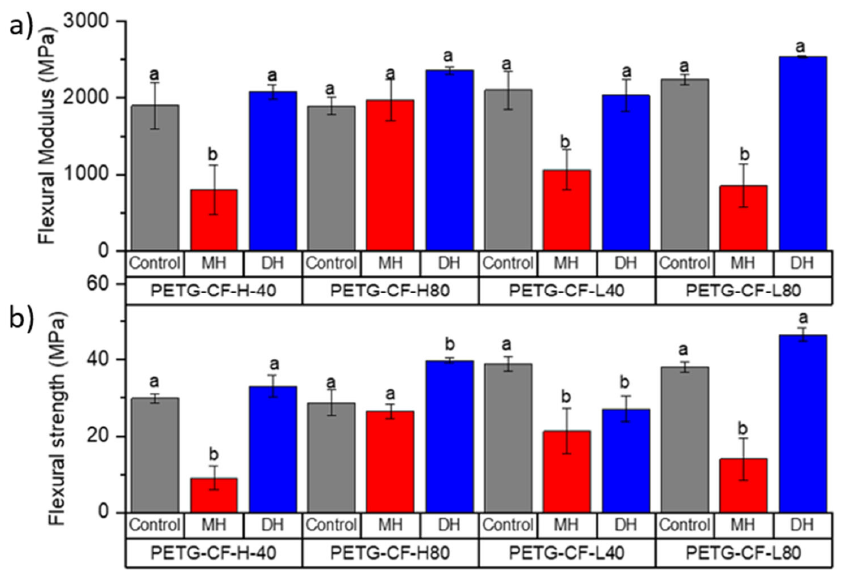
Figure 5. Change in the flexural modulus ( a ) and flexural strength ( b ) of the FDM dumbbells due to the DH or MH sterilization process as measured in the PETG 3D-printed samples. Grey bar: control sample; blue bar: dry heat sterilization; and red bar: moist heat sterilization. a,b Different letters show statistically significant differences between formulations ( p < 0.05).